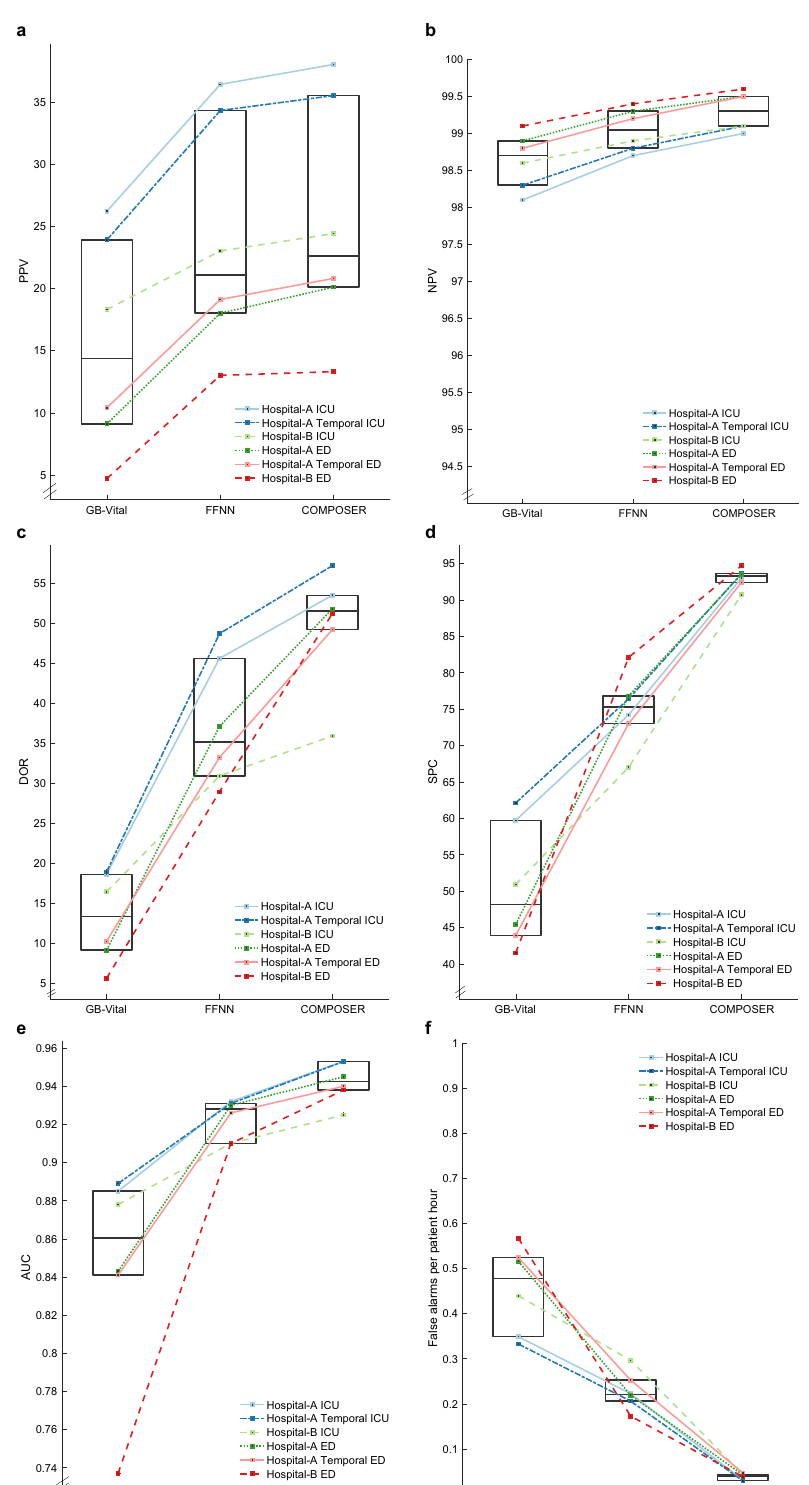
sepsis prediction model (ESPM) in use at Hospital-A during the same time period (FAPH of 0.132 vs 0.029) in the ICU. Moreover, COMPOSER achieved signi fi cantly better alarm noti fi cation lead-time, in advance of clinical suspicion of sepsis, compared to the ESPM model (see Table